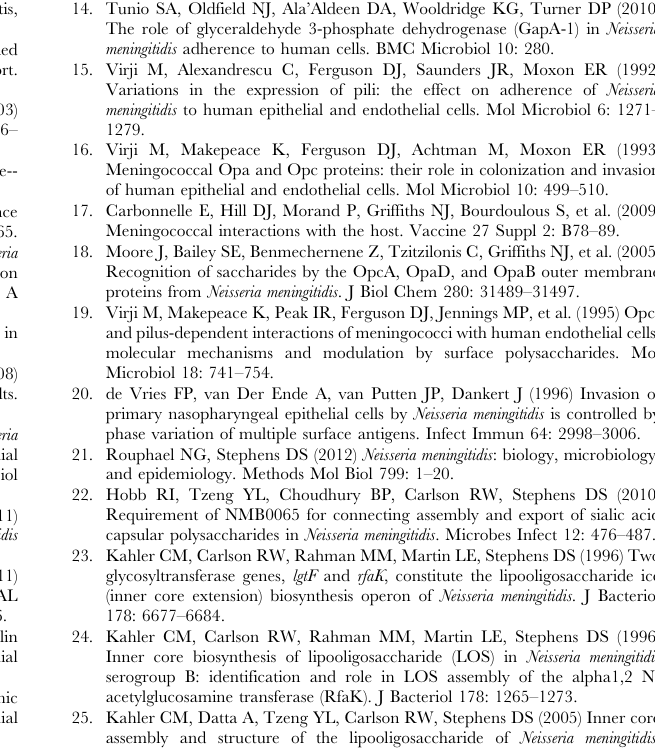
Figure S2 AMNIS ImageStream x can be used to identify single diplococci in an NMB-CDC sample under flow. Panel A: Bivariate plot of the bright field and scatter channels for the particles in focus (R1 focus). Panel B. Image gallery of hand tagged cells for analysis from the R2 region with bright field images displayed on the left and corresponding SYTOX Green image on the right. Panel C: Image gallery of particles in the R3 region with brightfield images displayed on the left and corresponding SYTOX Green image on the right. The example given here is for strain NMB, but the same analysis was performed for preparations of strain MC58 (not shown).